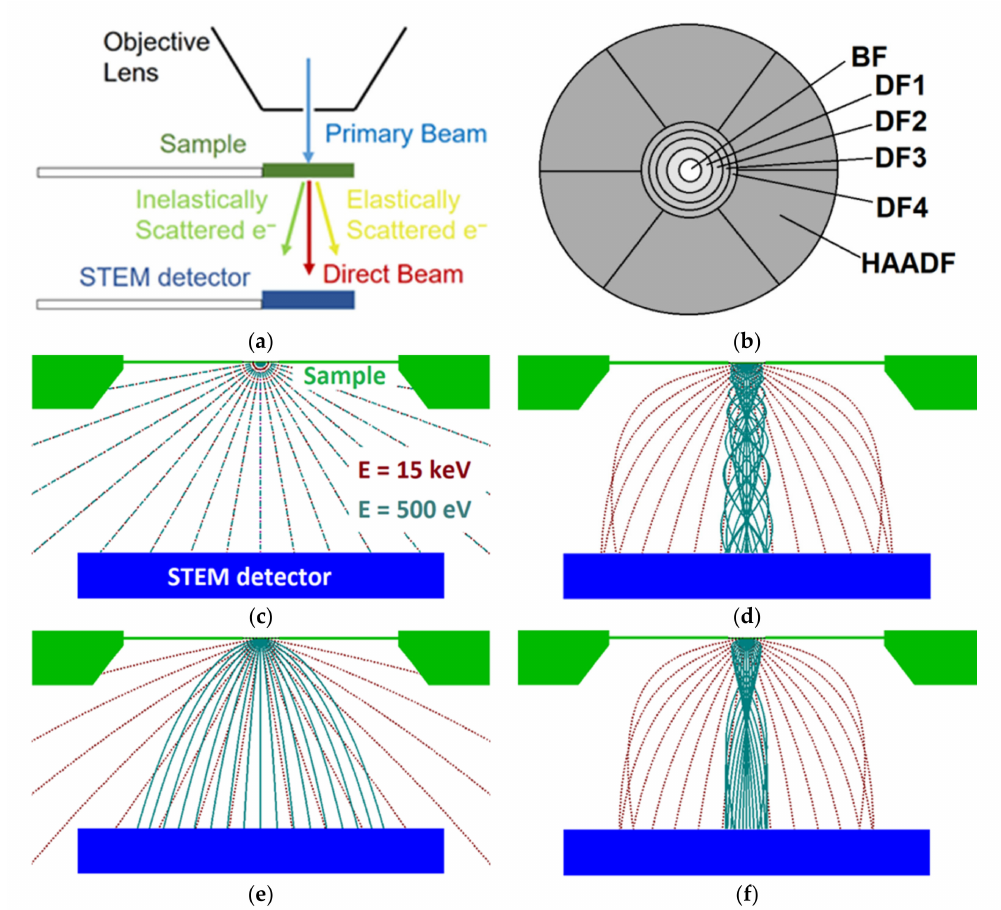
Figure 1. Scheme of the STEM detector and trajectory simulations for microscopic modes: ( a ) Simu- lated arrangement (side view); ( b ) STEM detector—segments (top view); simulated profiles of radial coordinate r of selected trajectories (polar angle from 0 to 90 deg with step 10 deg, two different energies: 15 keV red, 0.5 keV green) along the optical axis in the case of four available modes: ( c ) HR; ( d ) UHR; ( e ) HR + BD; ( f ) UHR + BD. The sample detector distance is 12.5 mm, and the potential at the sample is − 4 kV if BD mode is active and 0 V if not. The magnetic field is implicitly determined such that the beam is focused at the sample in the (corresponding) working distance of 4.5